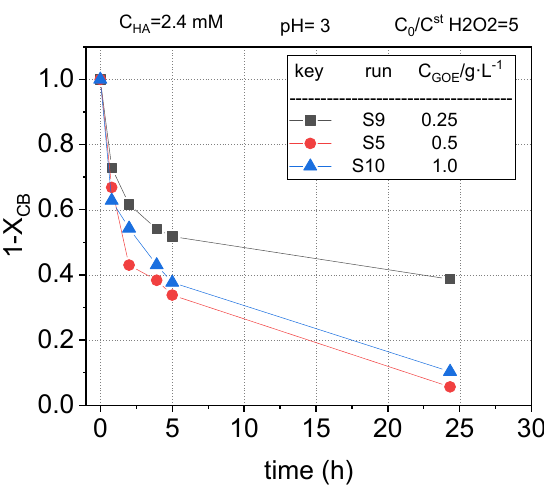
Figure 12. Remaining fractional chlorobenzene concentration ( 1 − X CB ) at di ff erent goethite concentrations vs. reaction time at pH 0 = 3, C HA = 2.4 mM and ( C H at room temperature (controlled at 22 ◦ C). Catalysts 2018 , 8 , x FOR PEER REVIEW